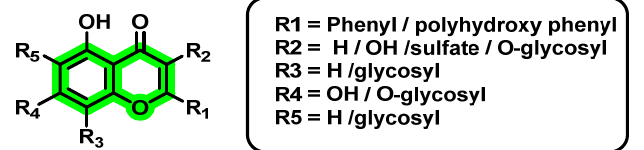
Figure 5. Common scaffold generated from Structure Activity Relationship study.